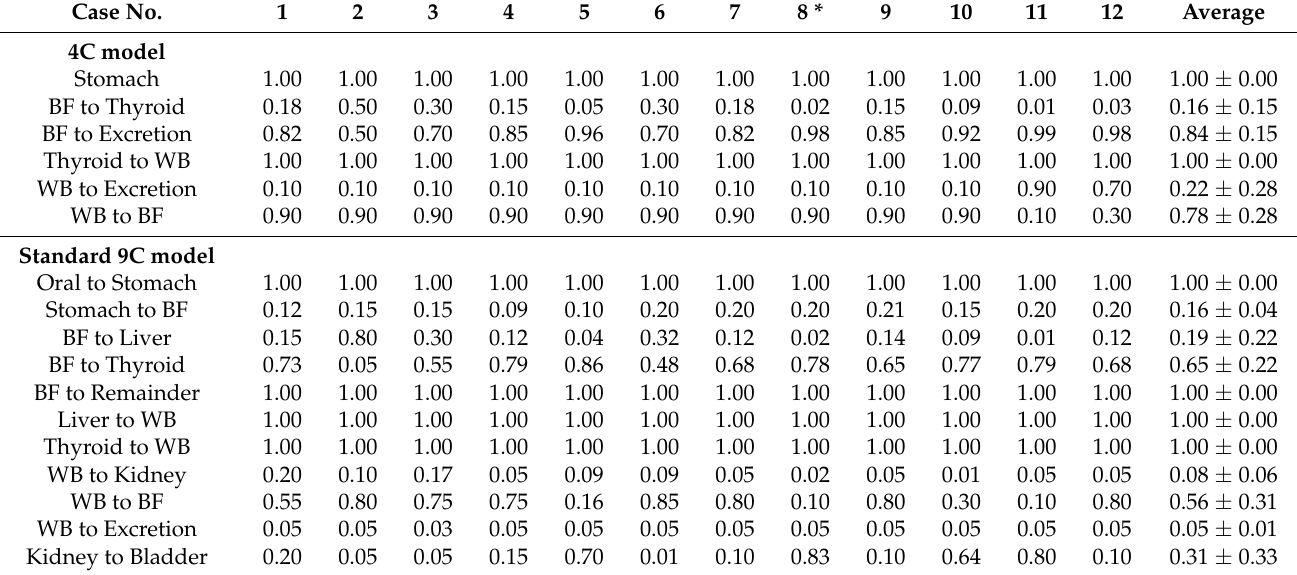
Table 3. The derived branching ratios and averages for the simultaneous time-dependent differential equations (cf. Equations (1)–(9)) as adopted in this work. * Case no. 8 was excluded from the calculations of average